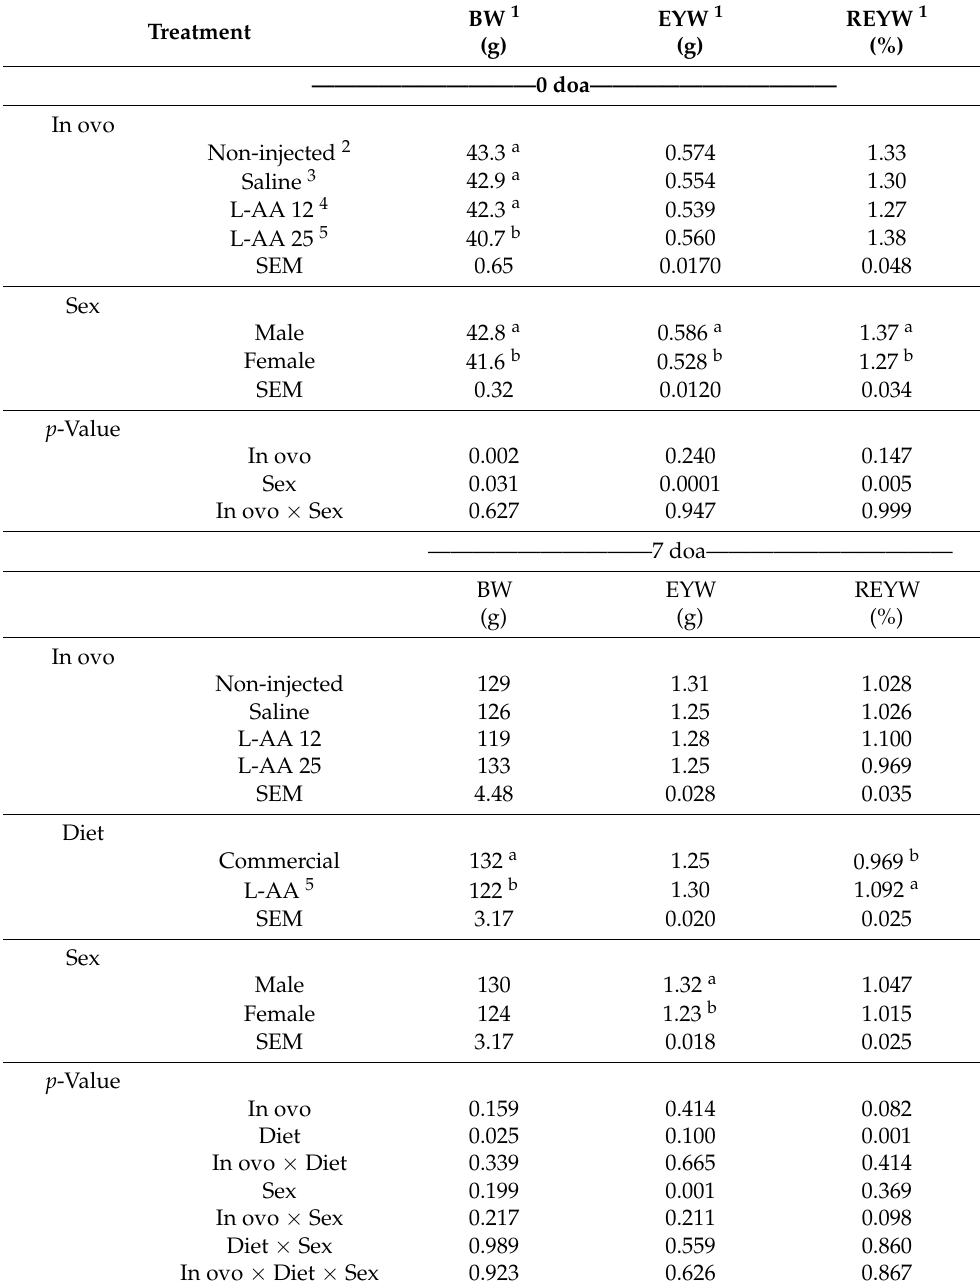
Table 5. Effects of treatment non-injected; saline-injected (saline); saline containing 12 mg of L- ascorbic acid (L-AA 12), or 25 mg of L-ascorbic acid (L-AA 25) at 17 days of incubation (doi) and either a commercial diet or a diet supplemented with 200 mg/kg of L-AA on the body weight (BW) and eye characteristics of male and female broilers at 0 days of posthatch